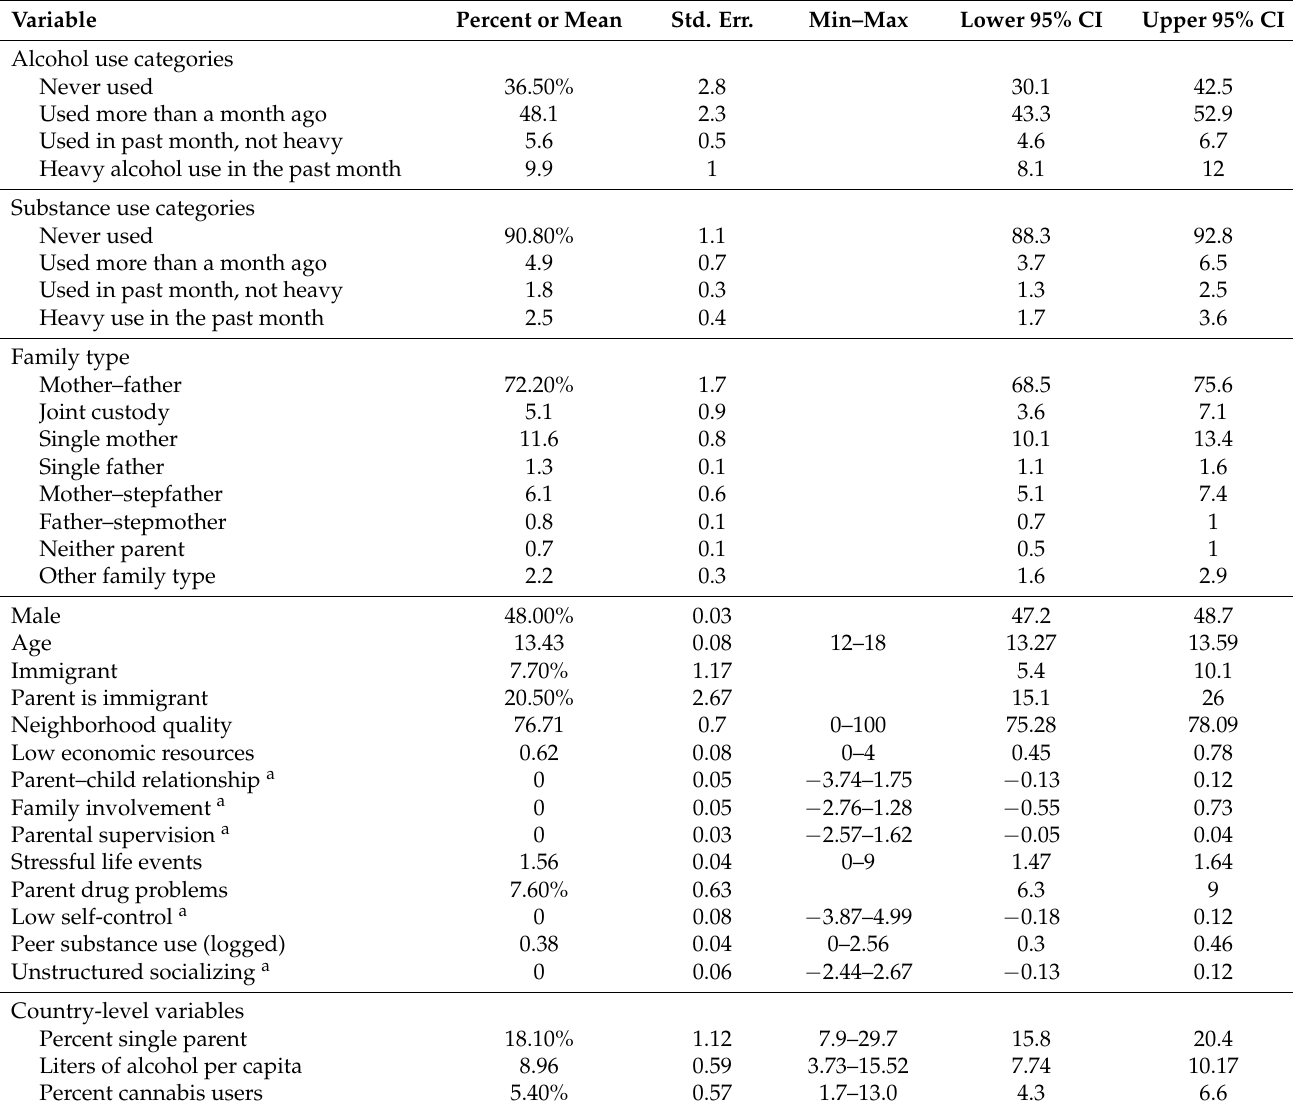
Table 1. Descriptive statistics, adolescents ages 12–18, ISRD-2 variables,